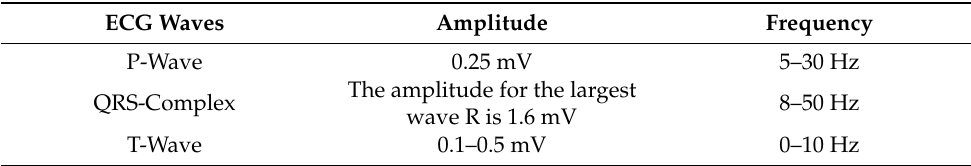
Figure 1. ECG signal components show the onset and offset of each wave. Table 1. The amplitudes and frequencies of ECG